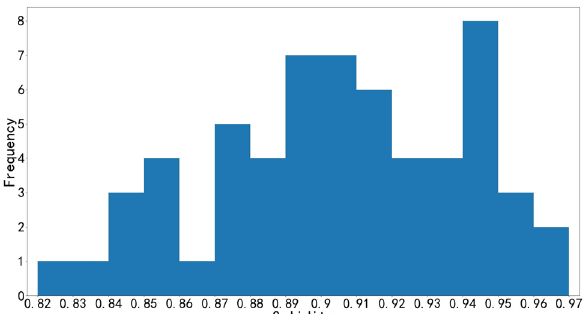
Figure 11. Histogram of limestone solidity distribution.